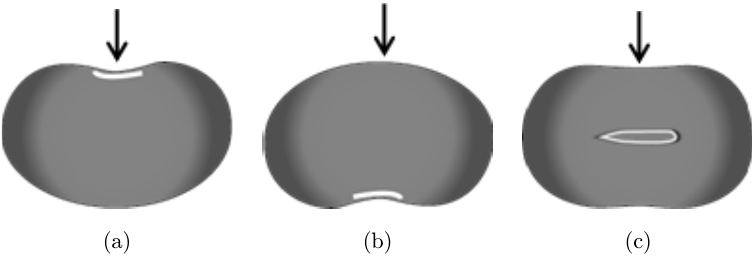
Fig. 2. Three orientations of mung bean seed for measurement: (a) hilum face-up, (b) hilum face-down and (c) hilum-parallel-to-